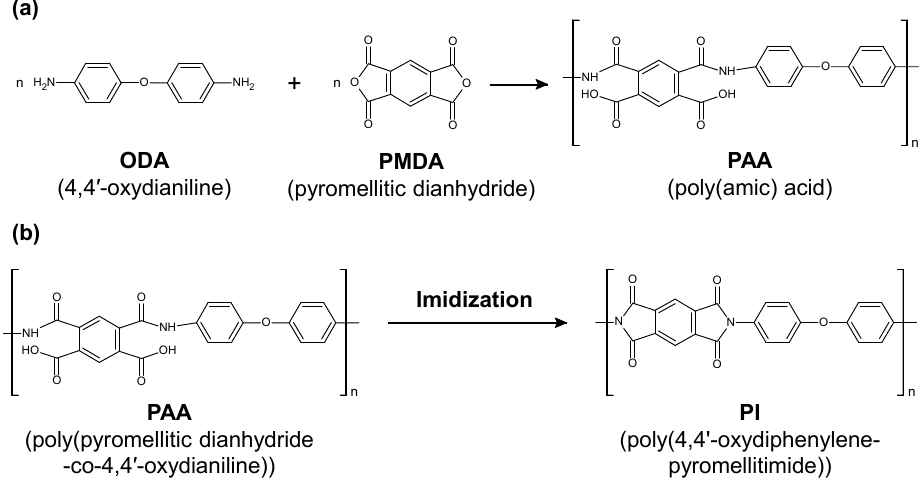
Figure 11. ( a ) Chemical structural change from poly(amic acid) to polyimide (PI). ( b ) Representative change from poly(pyromellitic dianhydride-co-4,4 ′ -oxydianiline) to poly(4,4’-oxydiphenylene- pyromellitimide) through baking.